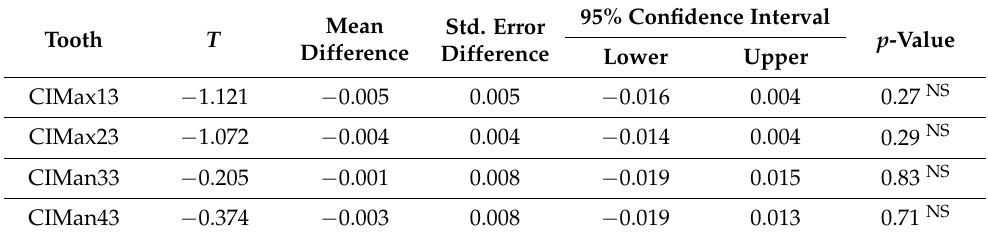
Table 7. The mean difference between two mean using independent sample-t-test